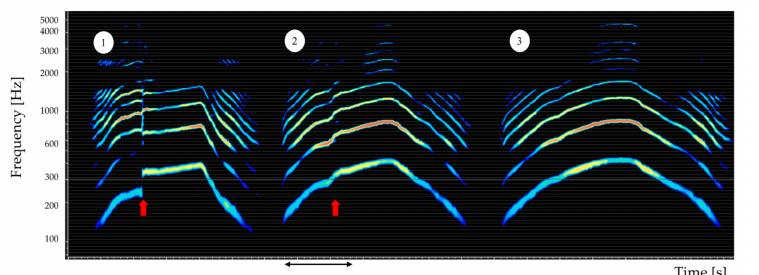
Figure 17. VoceVista Video Pro narrow-band spectrograms of ascending and descending glissandi sung by a male singer (1) with a voice break (red arrow), (2) with a minor instability (red arrow) and (3) with a smooth transition between